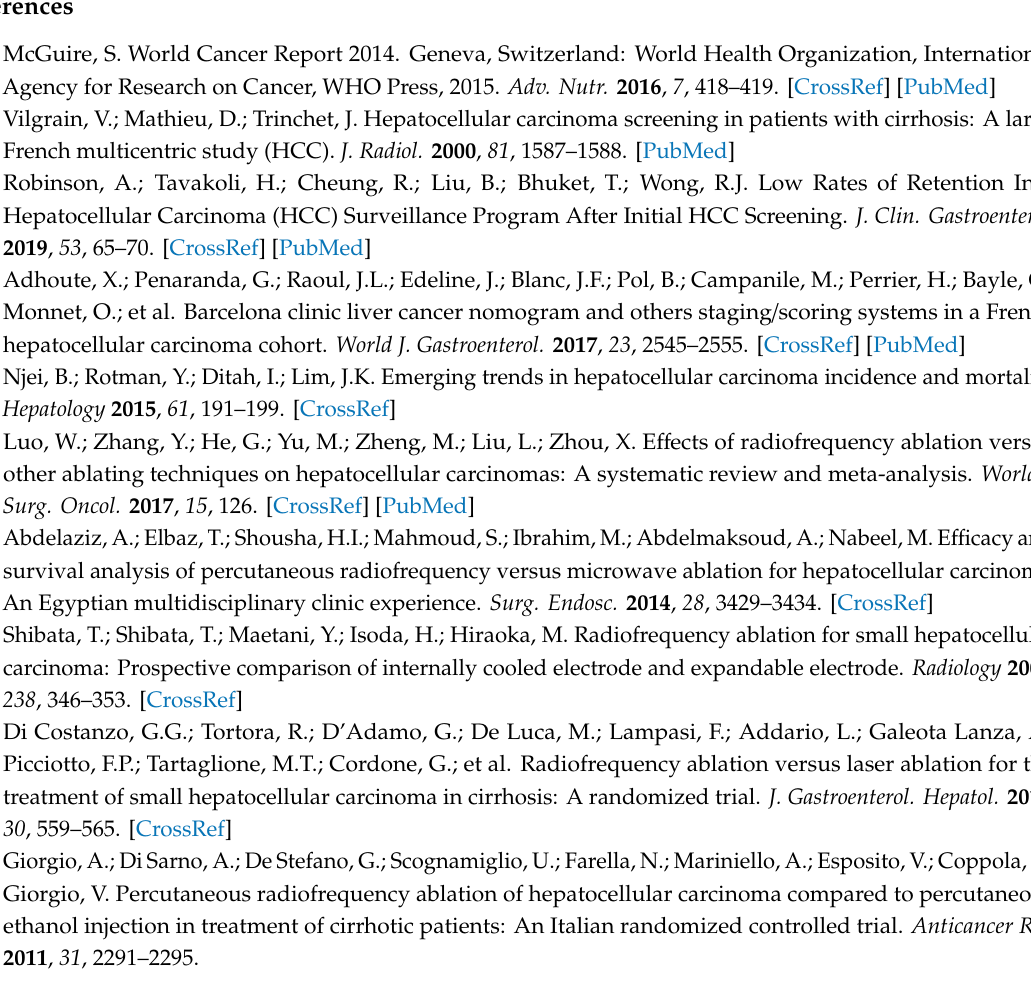
Table S1: Selected randomized trials comparing ablation techniques. Table S2: Selected randomized trials comparing di ff erent embolization